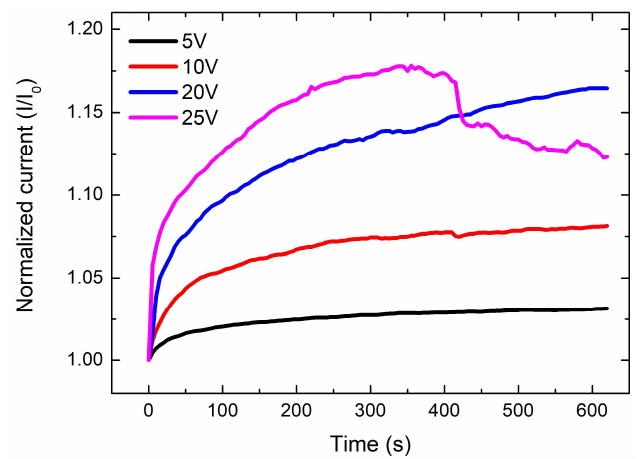
Figure 4. Change in normalized electric current of CNT nanocomposites as a function of curing time and applied voltages.